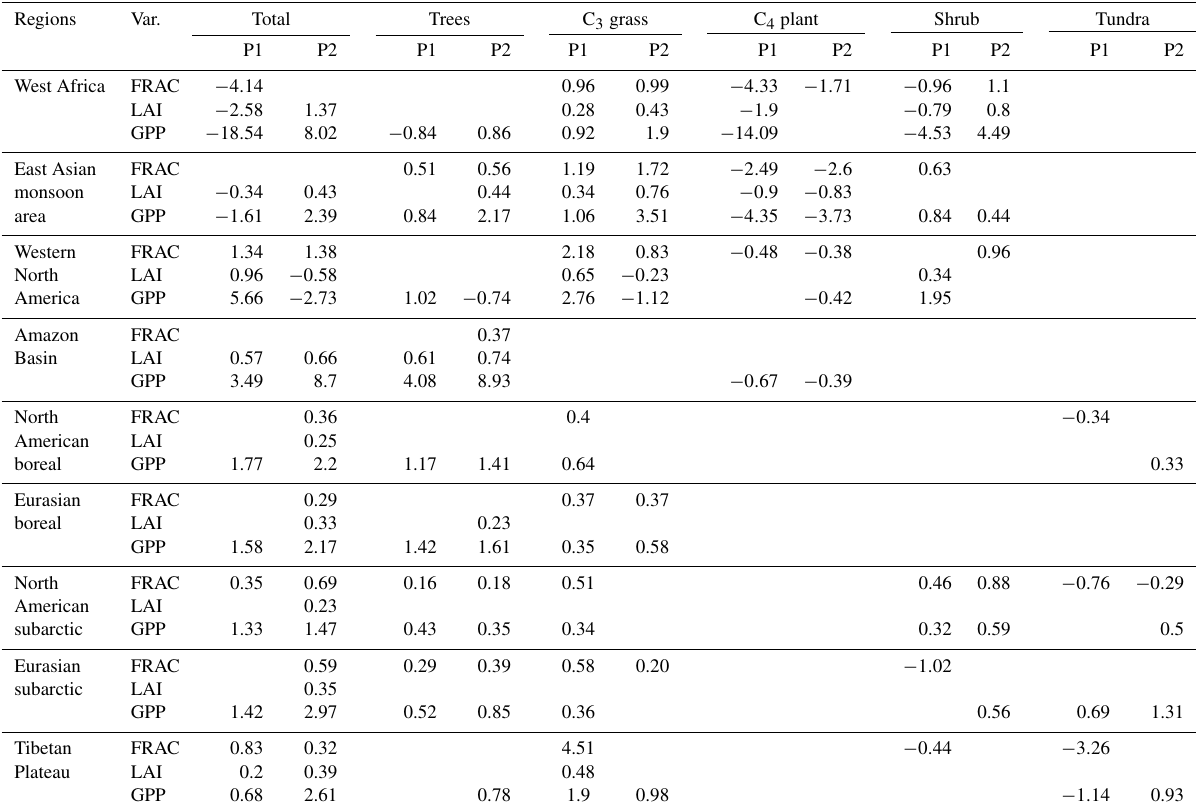
Table 4. Linear trend of vegetation FRAC, LAI and GPP changes during P1 (1958–1982) and P2 (1982–2007) in subregions ∗ . Regions Var. Total Trees C 3 grass C 4 plant Shrub Tundra West Africa